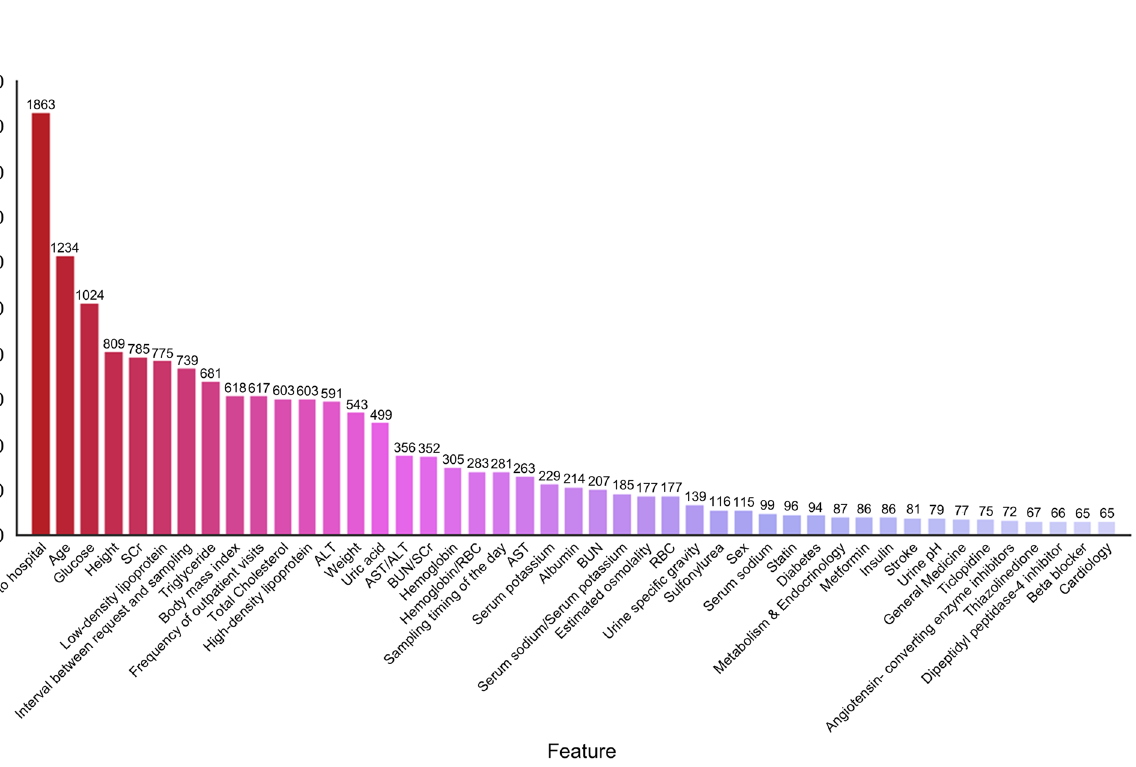
Figure 4. Top-ranked 45 features identified using the proposed XGBoost algorithm. SCr serum creatinine, ALT alanine transaminase, AST aspartate aminotransferase, BUN blood urea nitrogen, RBC red blood cell